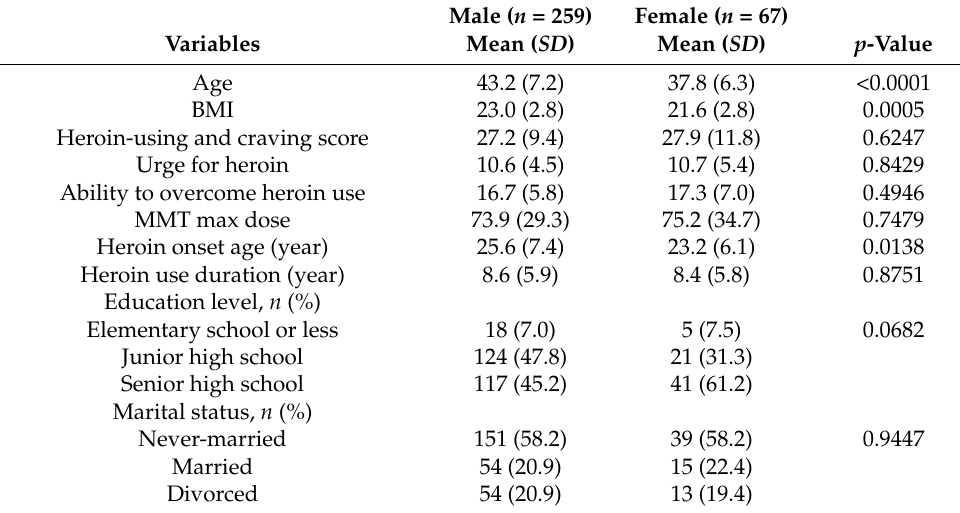
Table 1. Subject